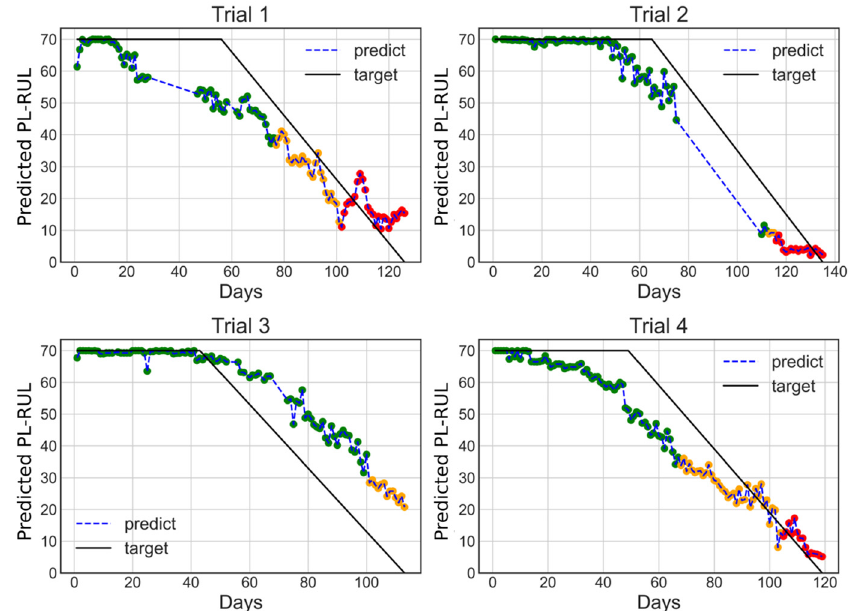
70 T days, trained on A/C dataset RUL